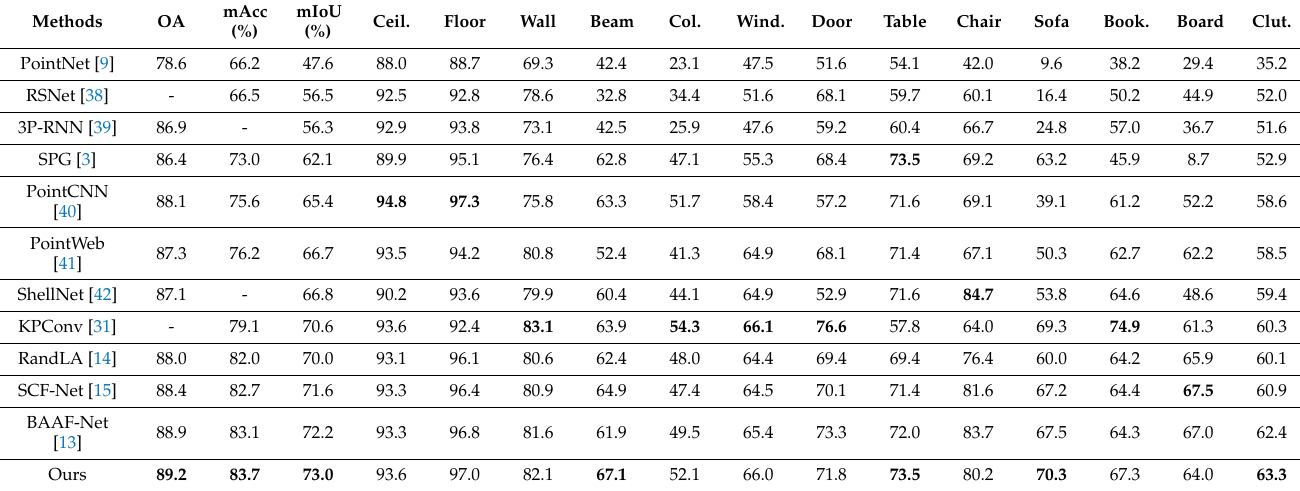
Table 1. Comparisons with state-of-the-art methods (6-fold cross-validation of S3DIS).